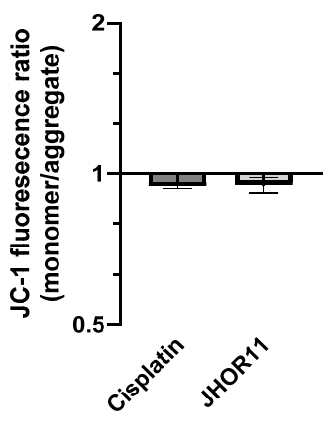
Figure 5. Mitochondrial potential evaluated by the JC-1 monomer/aggregate fluorescence ratio after 48 h incubation of A2780 cells with IC 50 of JHOR11. DMSO (0.1% ( v / v )) was the vehicle control and cisplatin 3.5 µ M was used as the positive control. Data were normalized to the vehicle control, and bars represent the mean ± SD of at least three independent experiments.